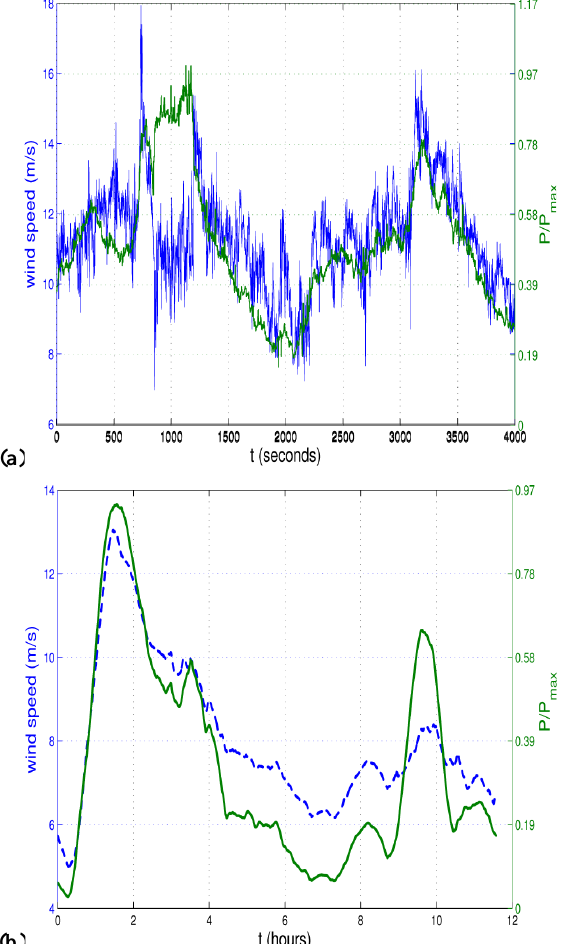
Fig. 1. Two examples of simultaneous wind power data: (a) simul- taneous time series sampled at 1Hz; (b) moving averages of simul- taneous time series, over a time period T = 10 4 s ’